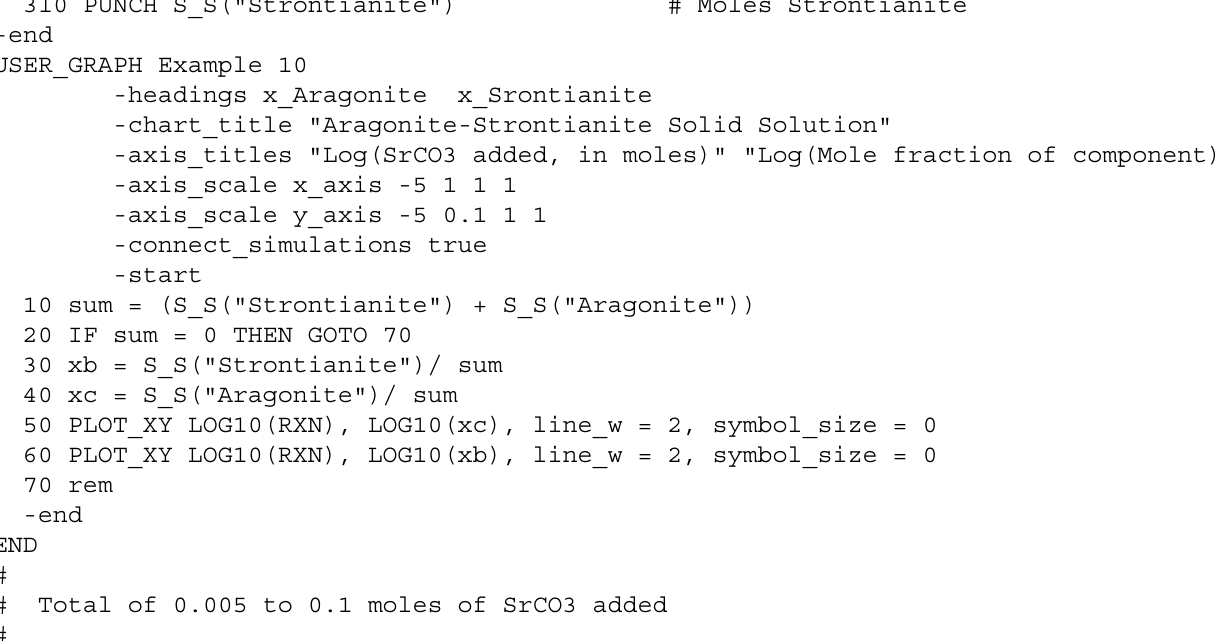
Table 29. Input file for example